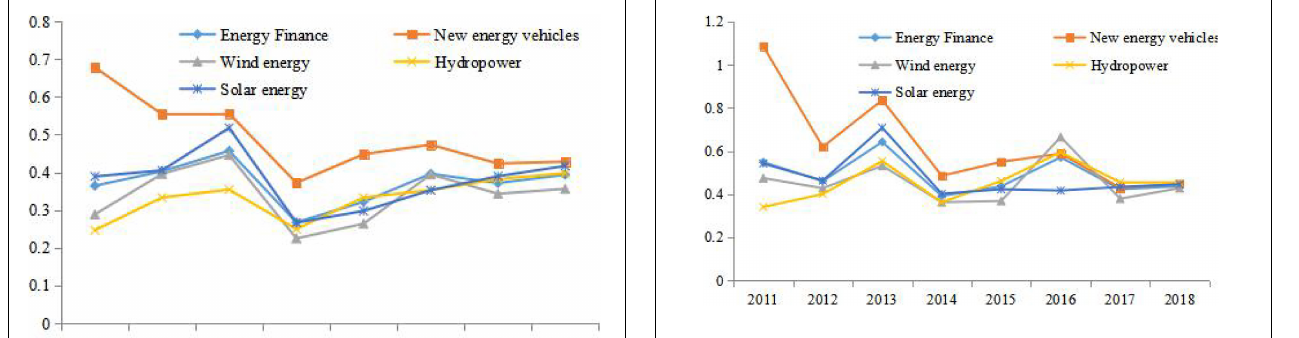
FIGURE 3 | Pure technical efficiency of financial support for new energy industries.